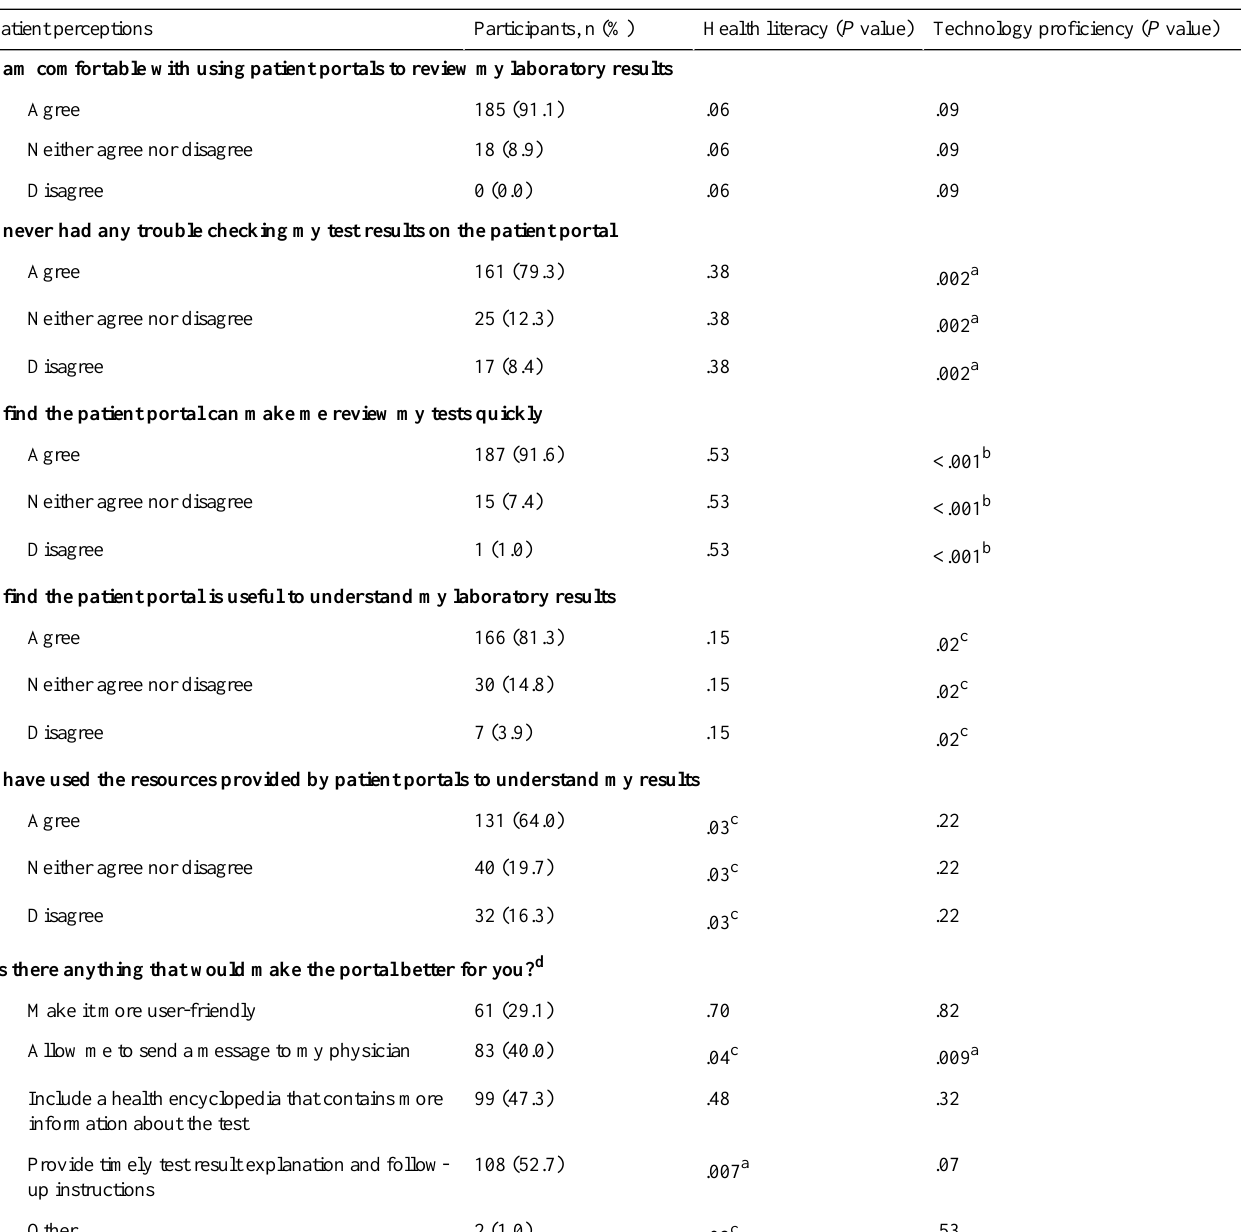
Table 5. The association between 2 factors (health literacy and technology proficiency) and patient perceptions of using patient portals to understand and review laboratory test results